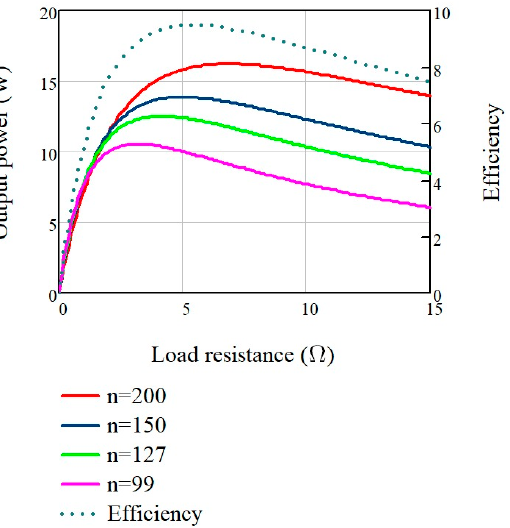
Figure 9. The relationship between load resistance ratio, TEG system power output, and thermoelec-